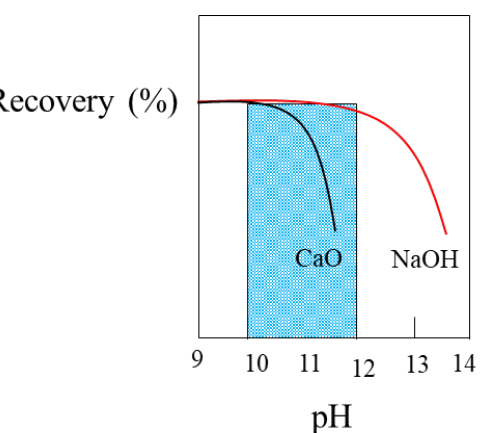
Figure 22. Recovery of pyrite with lime and caustic soda (adapted from Coloma Á lvarez [102]).